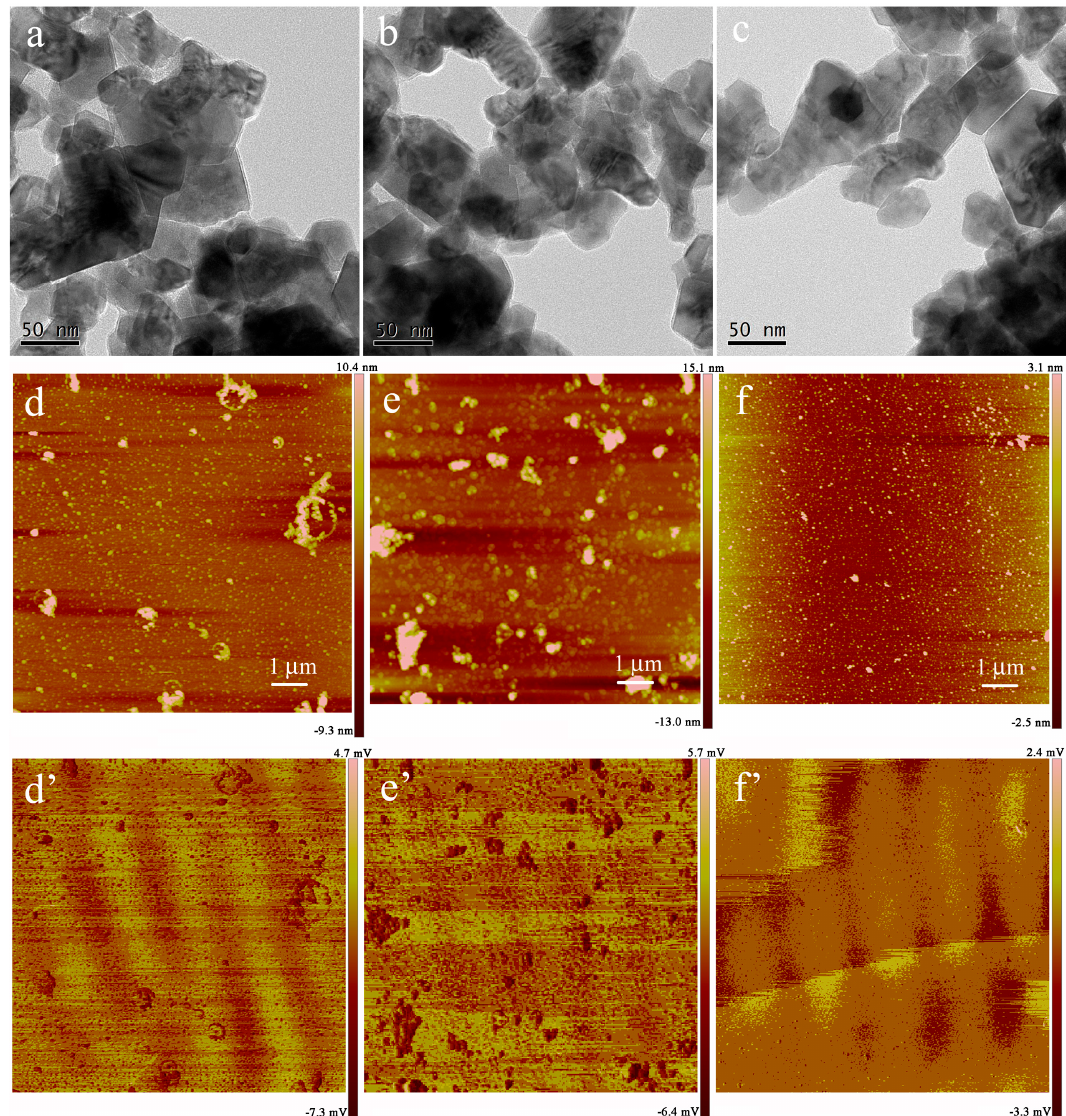
Figure 3. TEM images and tapping mode atomic force microscopy (AFM) images of the transferred films of MXene-SO3H/MB ( a , d , d’ ), MXene-SO3H/RhB ( b , e , e’ ) and MXene-SO3H/ST ( c , f , f’ ) on copper grid or freshly cleaved mica surface, respectively.